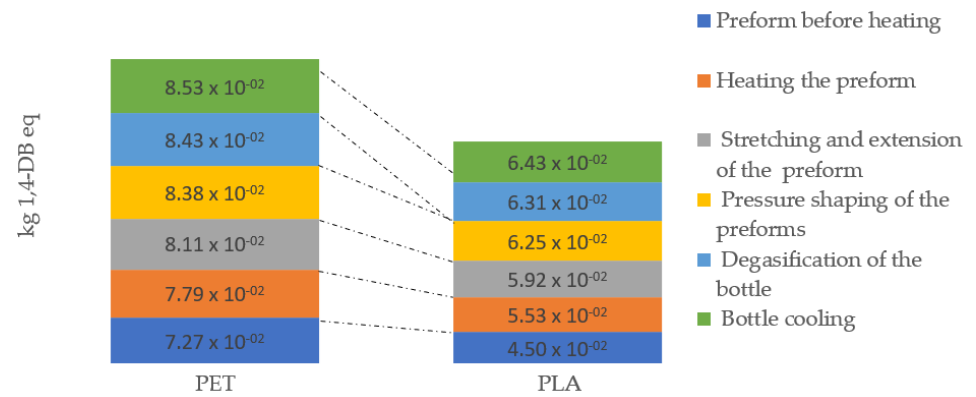
Figure 9. Human toxicity emissions throughout the entire bottle shaping